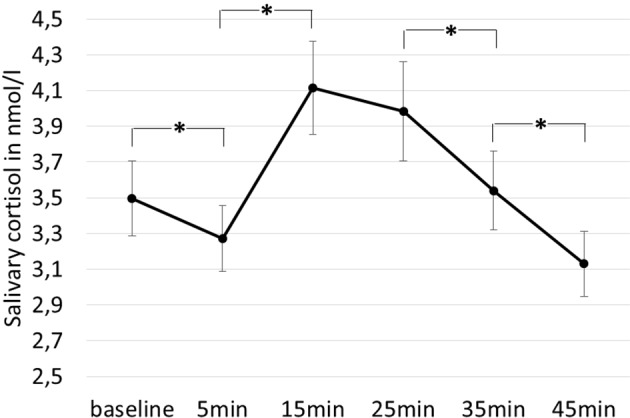
Changes in cortisol over time (baseline = t1, 5 min = t2, 15 min = t3, 25 min = t4, 35 min = t5, 45 min = t6). Error bars indicate one standard error. Stars indicate significant differences between time points.